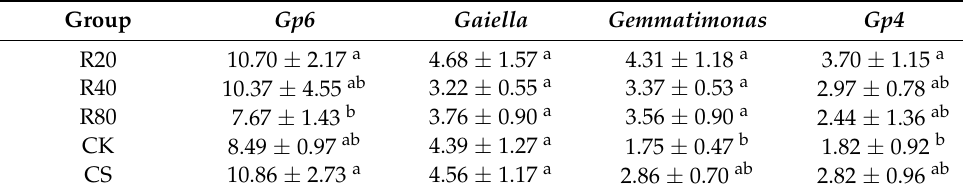
Table 5. Relative abundances of the four dominant genera in the five groups of soils.